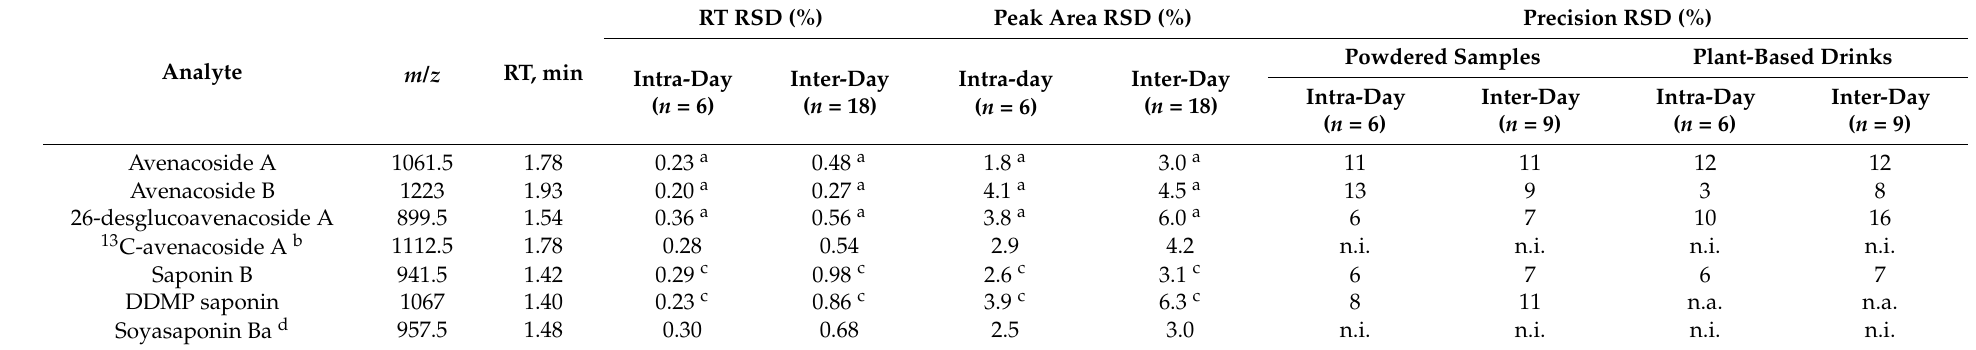
Table 3. Repeatability of retention times (RT) and peak areas of saponins, and precision of the whole method.